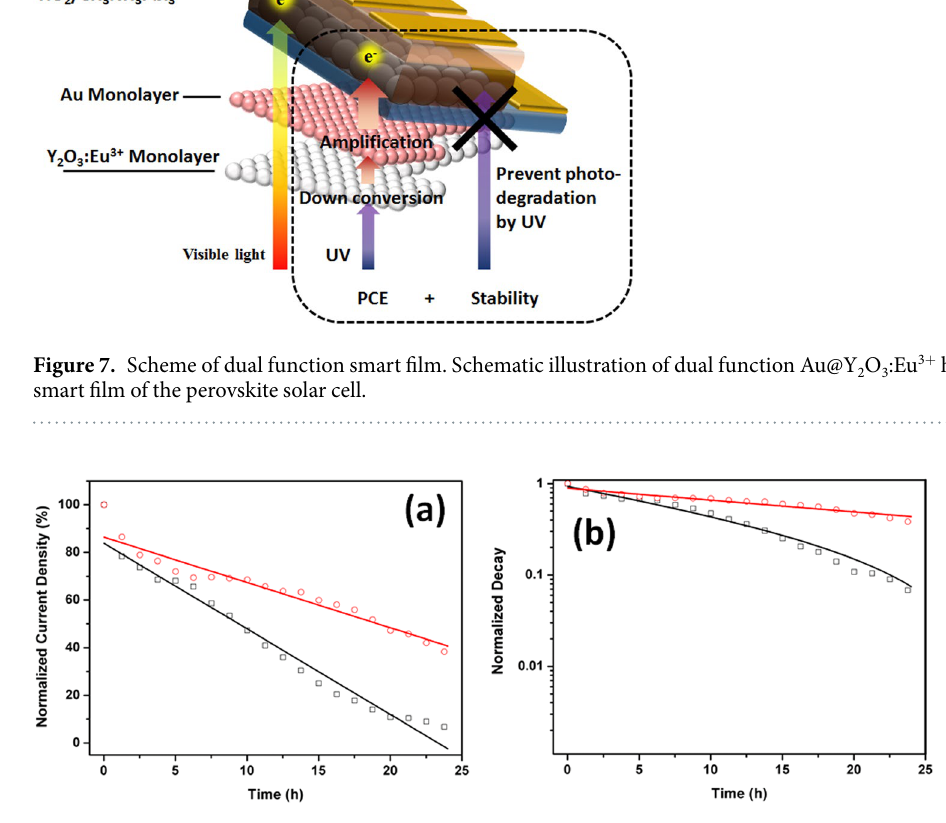
Figure 8. Long-term stability. Comparison of long-term stability ( a ) and time-dependent exponential decay curves ( b ) under UV light illumination between standard perovskite solar cell (black) and with Au@Y 2 O 3 :Eu 3 + dual-hybrid film